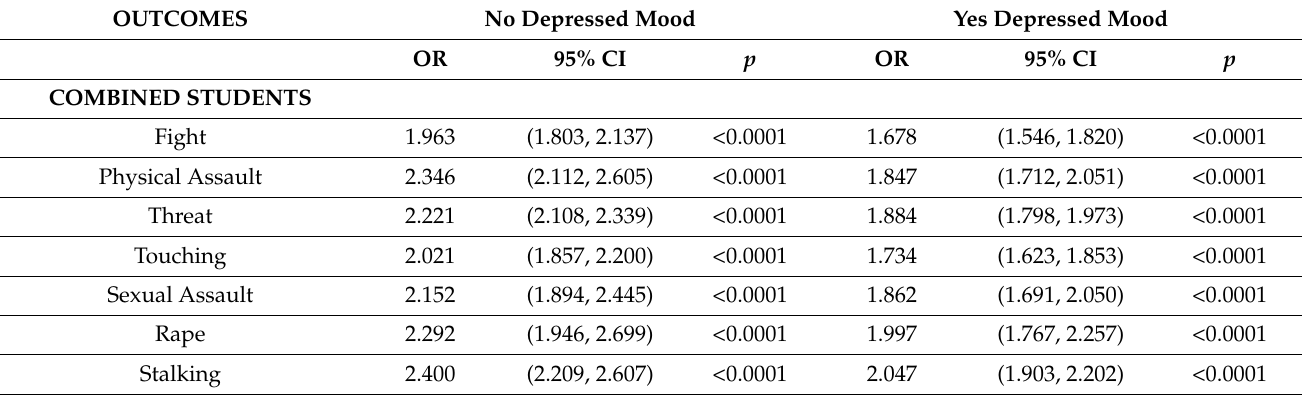
Table 3. Association between depressed mood and sleep difficulties: three categories of student status: combined, student non-athlete and student athlete (controlling for alcohol